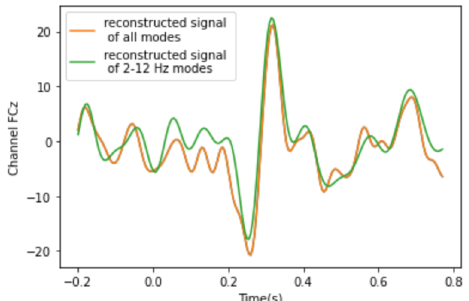
Figure 4. The error between the original signal and the reconstructed signal by DMD. (Take the recording in session 2 of subject 3 in the monitoring error-related potentials dataset as an